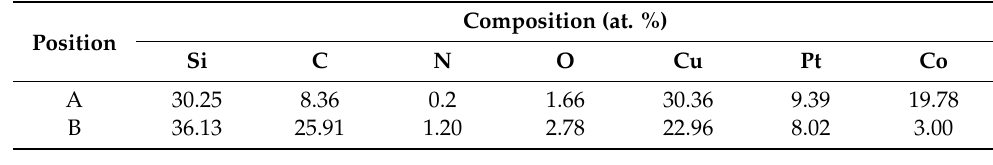
Figure 11. TEM image ( a ) and SAED pattern ( b ) of SiC nanowires, where ( c ) is HRTEM image of area “B” labelled in ( a ), and ( d ) is a magnified HRTEM image of area “P” labelled in ( c ). Table 3. The EDS results of the points marked in Figure 11a.